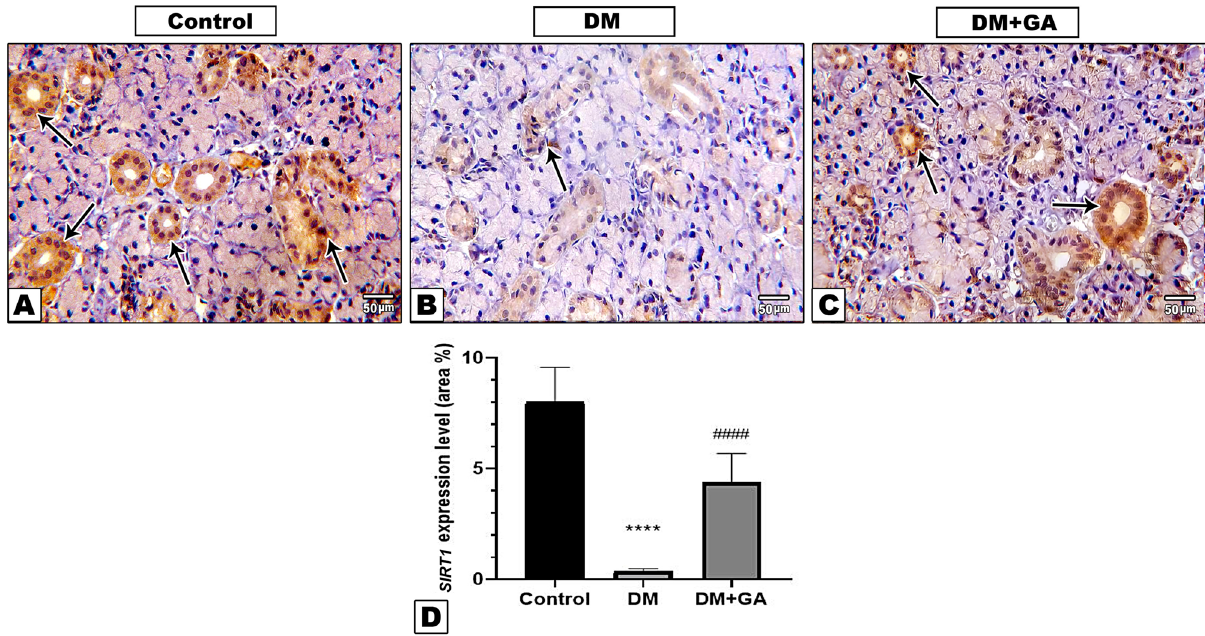
Figure 4. Immunostained SMG sections with SIRT1 showing positive nuclear expression of SIRT1 in both control and GA group (arrows) ( A , C ). Diabetic group ( B ) showed reduction of ductal expression (arrow) ( SIRT 1, IHC, × 20). ( D ) Quantitative analysis of SIRT 1 immunostaining (%area). Data were expressed in mean ± SE. P < 0.05 is considered significant. ****Significant compared to control group at P < 0.0001, #### Significant compared to diabetic group at P <